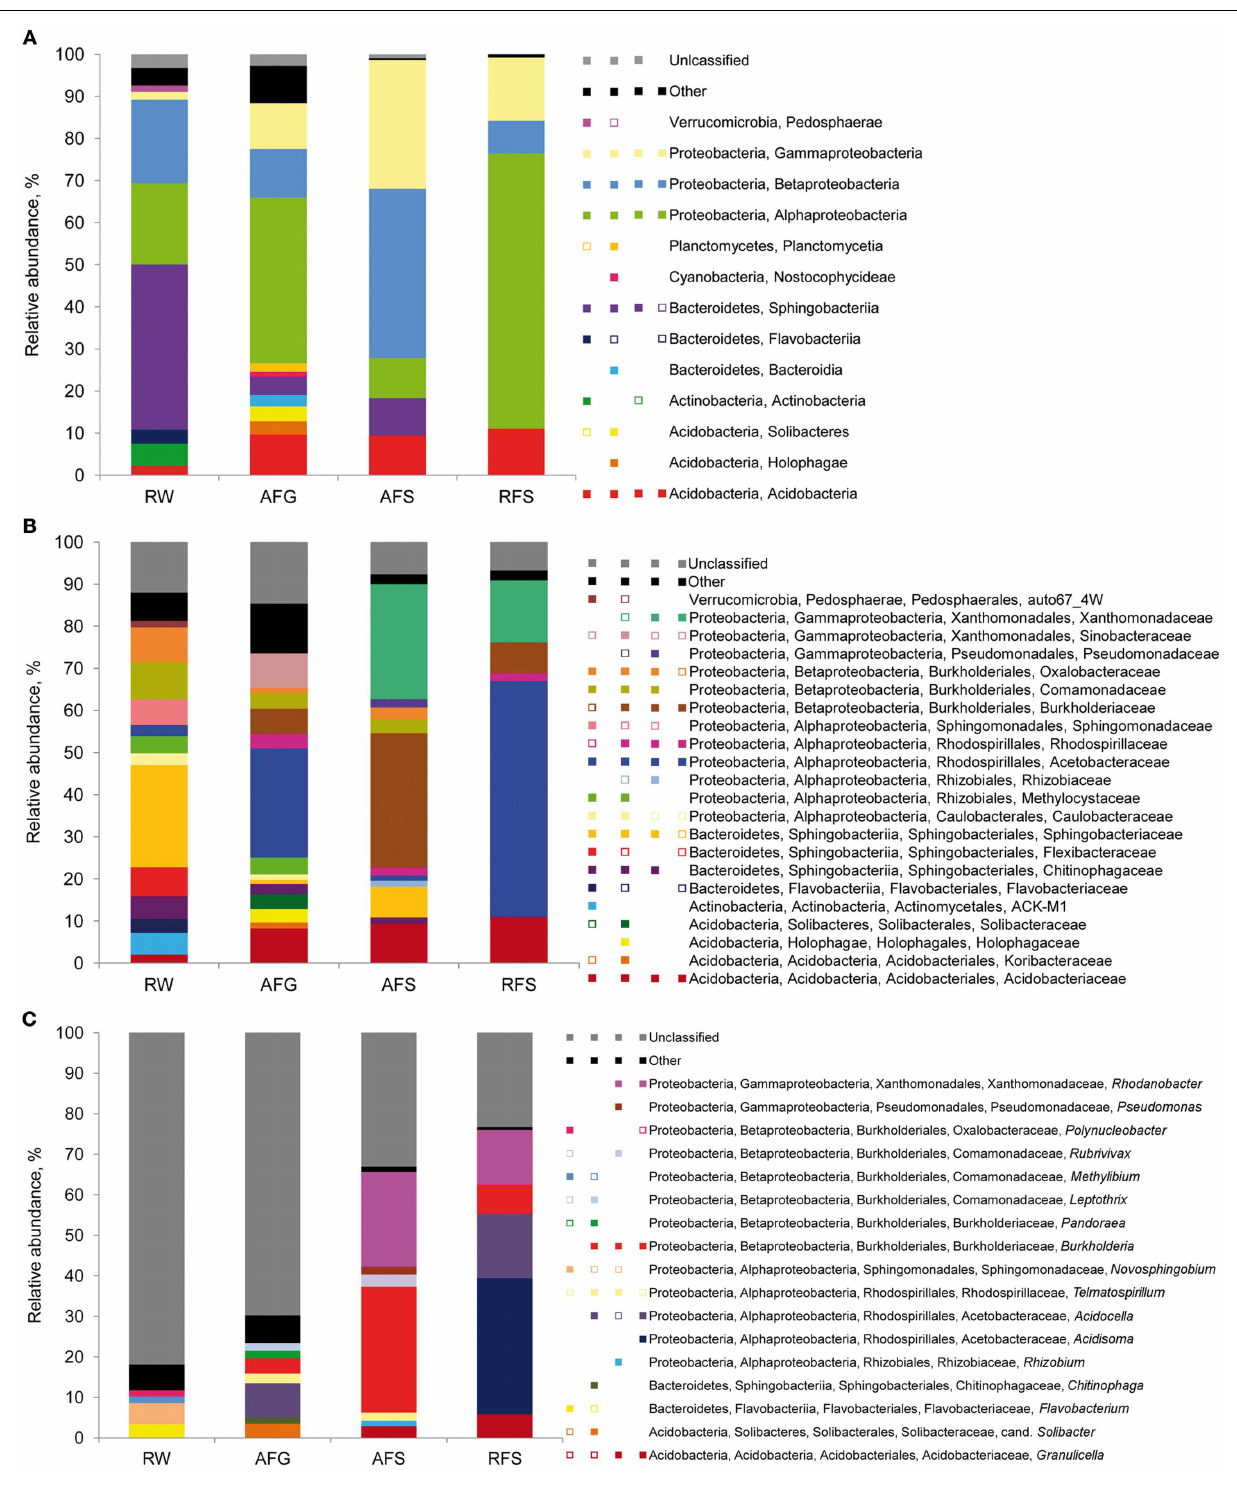
FIGURE 5 | Taxonomic classification of bacterial communities of Sphagnum mosses and flark water. Bar charts represent the composition of 16S rDNA pyrosequencing libraries of Bacteria classified at class (A) , family (B) and genus (C) level using RDP-classifier with a confidence threshold of 80%. Multi-colored charts in the legend